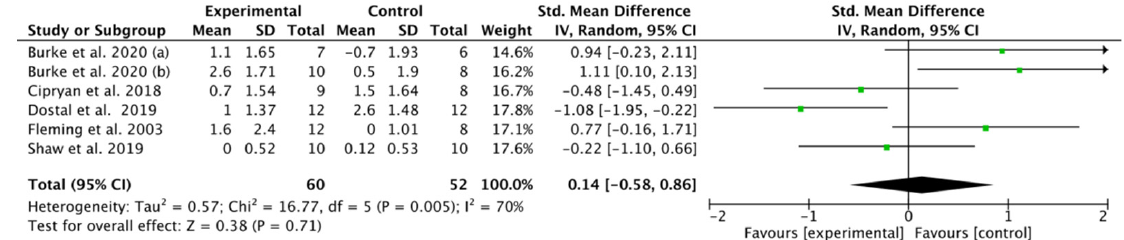
Figure 7. Effect of the ketogenic low-carbohydrate, high-fat (K-LCHF) diet on rating of perceived exertion (RPE) during graded exercise test (GXT); CI: confidence interval; SMD: standardize mean difference.